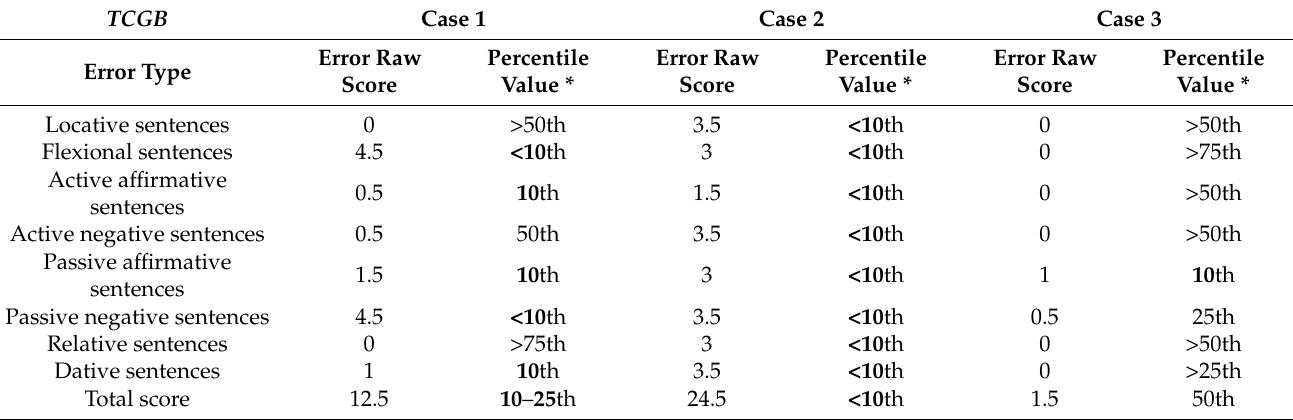
Table 2. Results (total error raw score, error raw scores for each type of sentence, and percentile values) for the TCGB in the three deaf children with